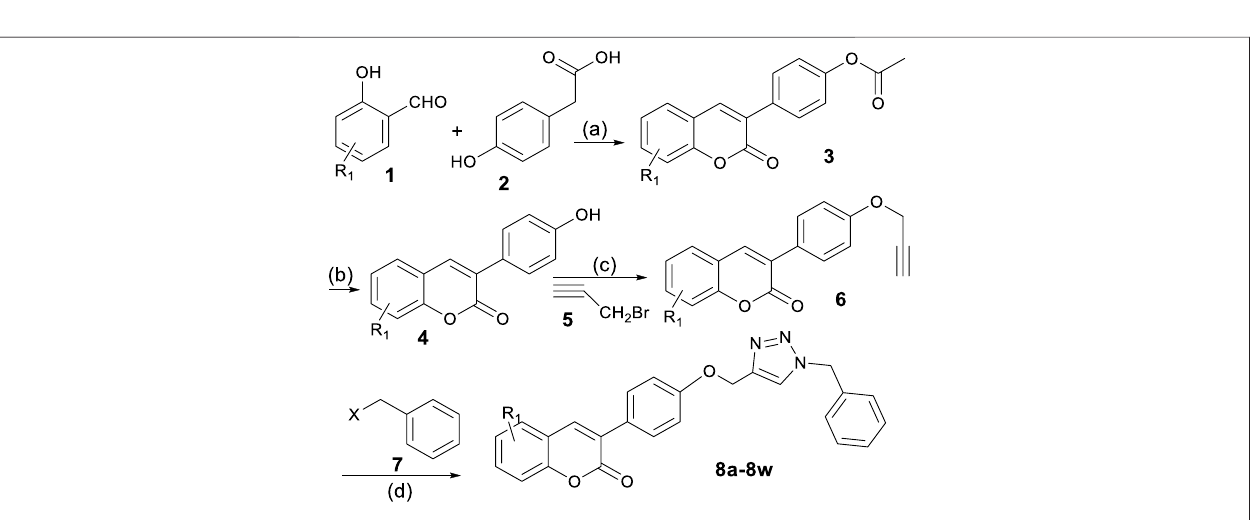
SCHEME 1 | Synthesis of compounds 8a - 8w . (A) KOAc, Ac 2 O, re fl ux, 4 h; (B) HCl (2N), MeOH, re fl ux, 3 h; (C) K 2 CO 3 , DMF, 60 – 65 ° C, 4 h; and (D) sodium ascorbate (NaAs),